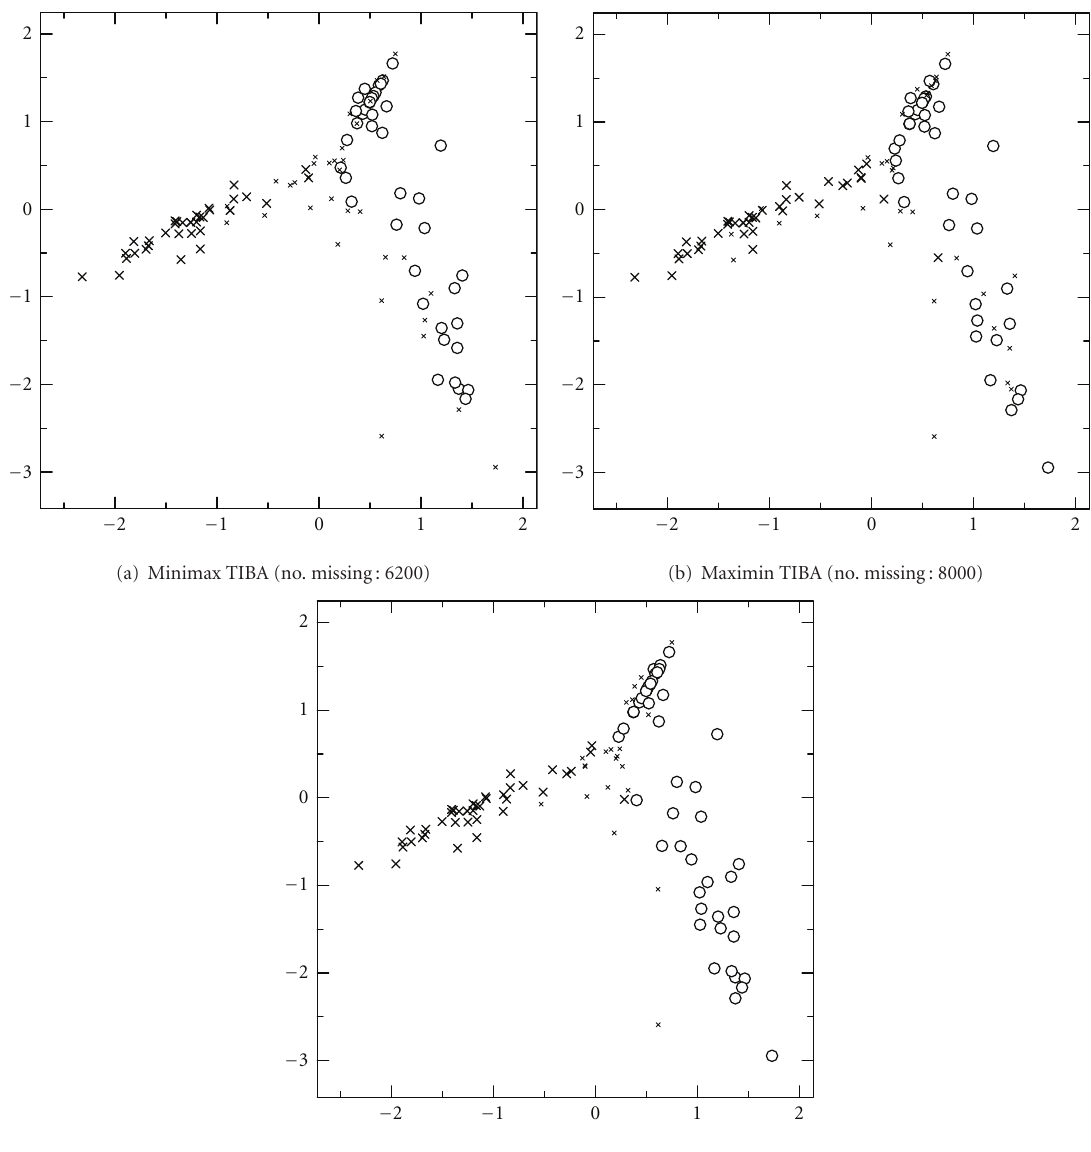
Figure 5: Comparison of cluster partition from incomplete “Kokoro” text data derived with Jaccard’s coe ffi cient imputed by three TIBAs.